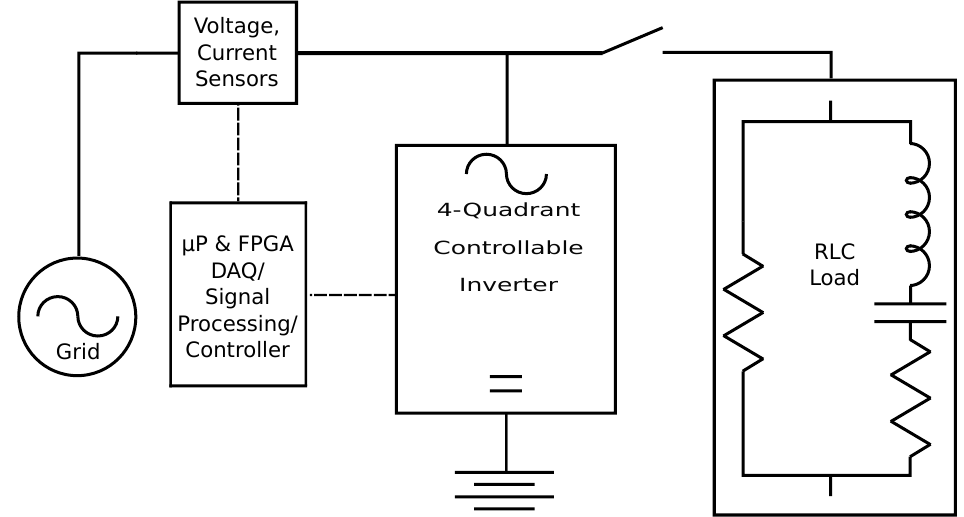
Figure 2. Test system configuration of inverter, grid, load, sensors, and microcontroller implemented at SyGMA Lab at